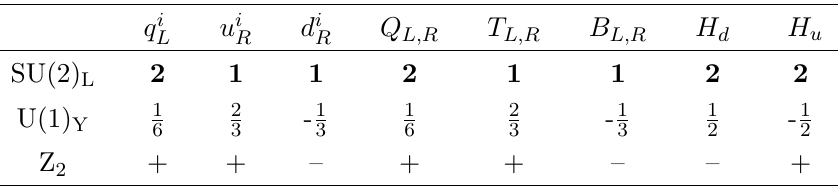
Table 1 . Quantum numbers of standard model quarks ( q i quarks and the two Higgs doublets. The electric charge is given by Q = T 3 + Y , where T 3 is the weak isospin, which is +1/2 for the (cid:12)rst component of a doublet and -1/2 for the second component.